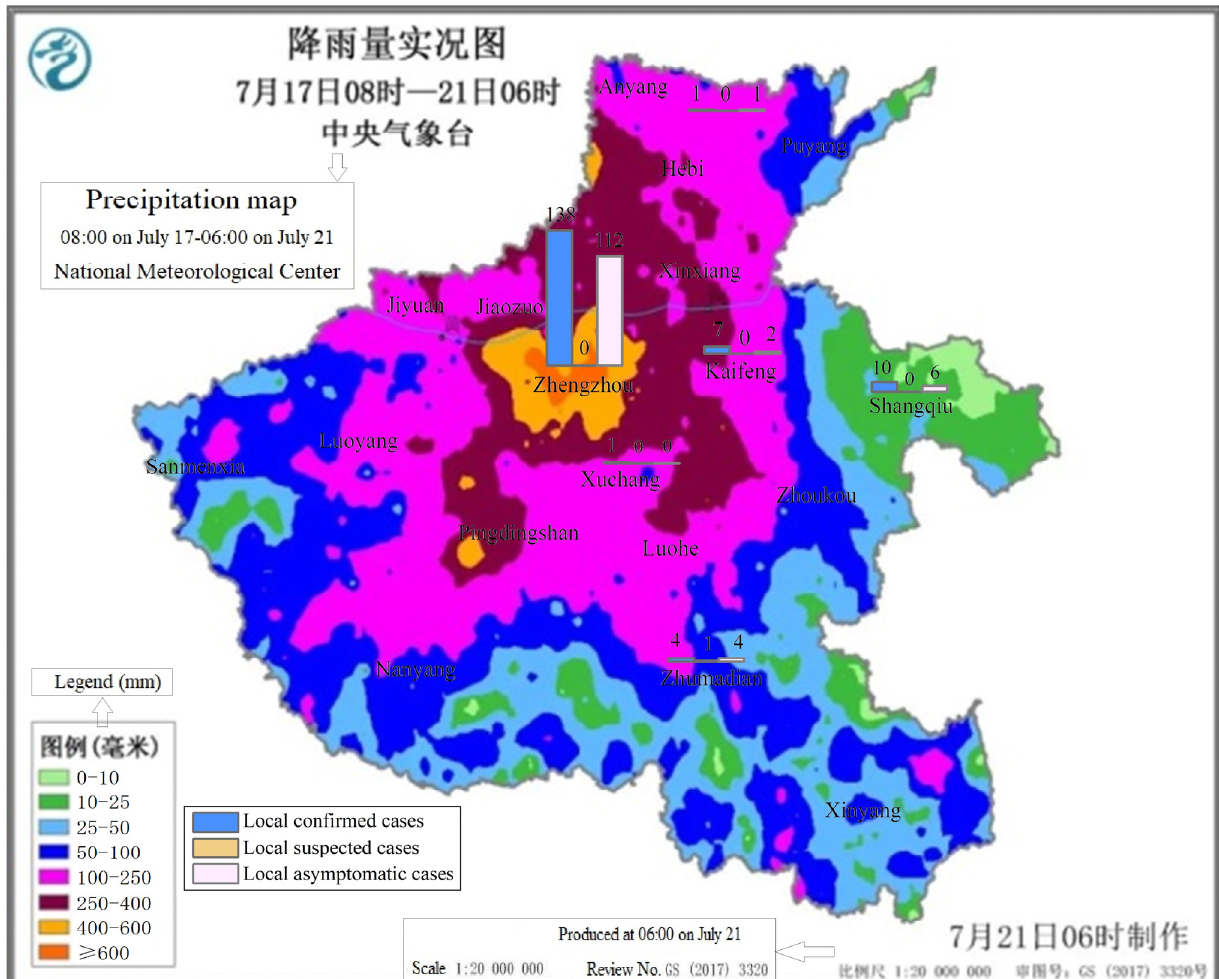
Figure 7. Distribution of local pandemic cases overlaid on the precipitation map.